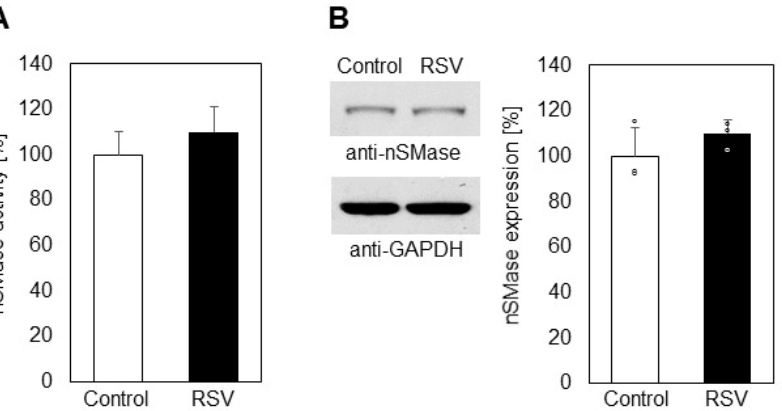
Figure 2. Changes in the activity ( A ) and protein expression ( B ) of neutral sphingomyelinase (nSMase) in control (white bars) and resveratrol-treated (black bars) A549 cells. Values are expressed as % change of controls (100%). Representative images from Western blot analysis with specific antibodies to neutral sphingomyelinase (nSMase) are shown in the left part of panel B. Reaction with anti-glyceraldehyde-3-phosphate dehydrogenase antibodies (anti-GAPDH) was used as an internal control for loading; ( ᵒ ) stands for the values from each independent experiment, obtained by pooling of three replicate samples. Values represent means ± SD. The differences between the obtained values were not statistically significant.